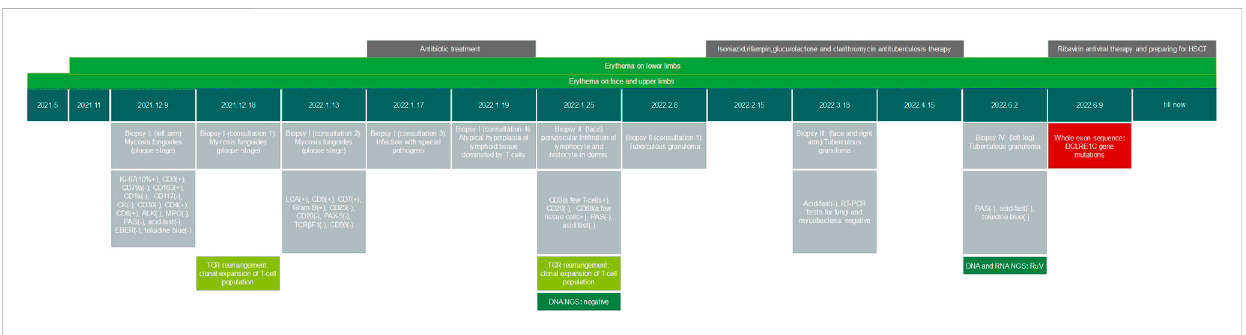
FIGURE 2 Timeline of the patient ’ s